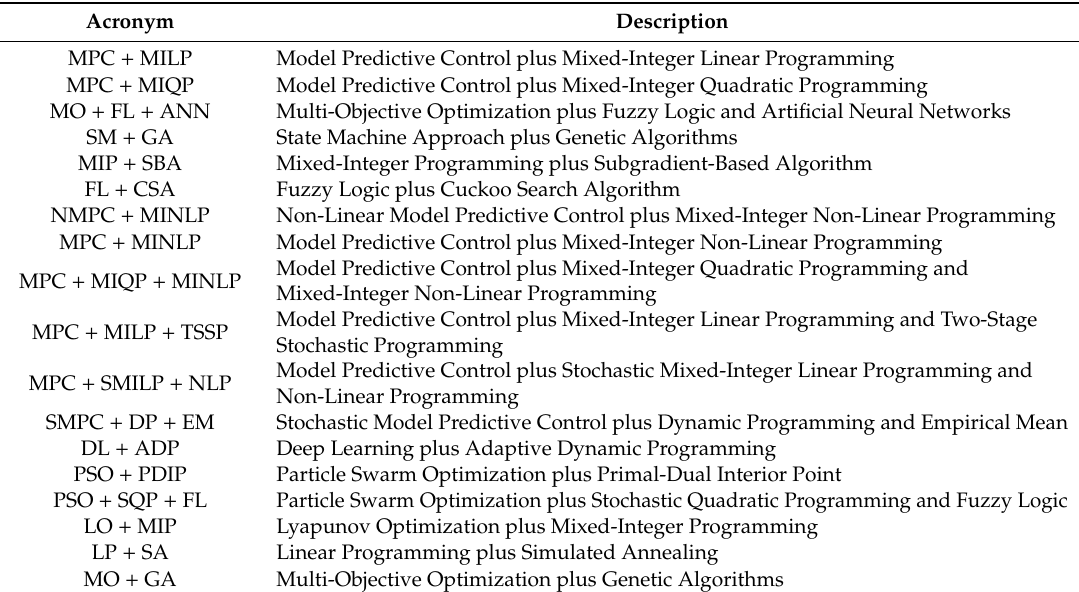
Table A3. Hybrid method’s